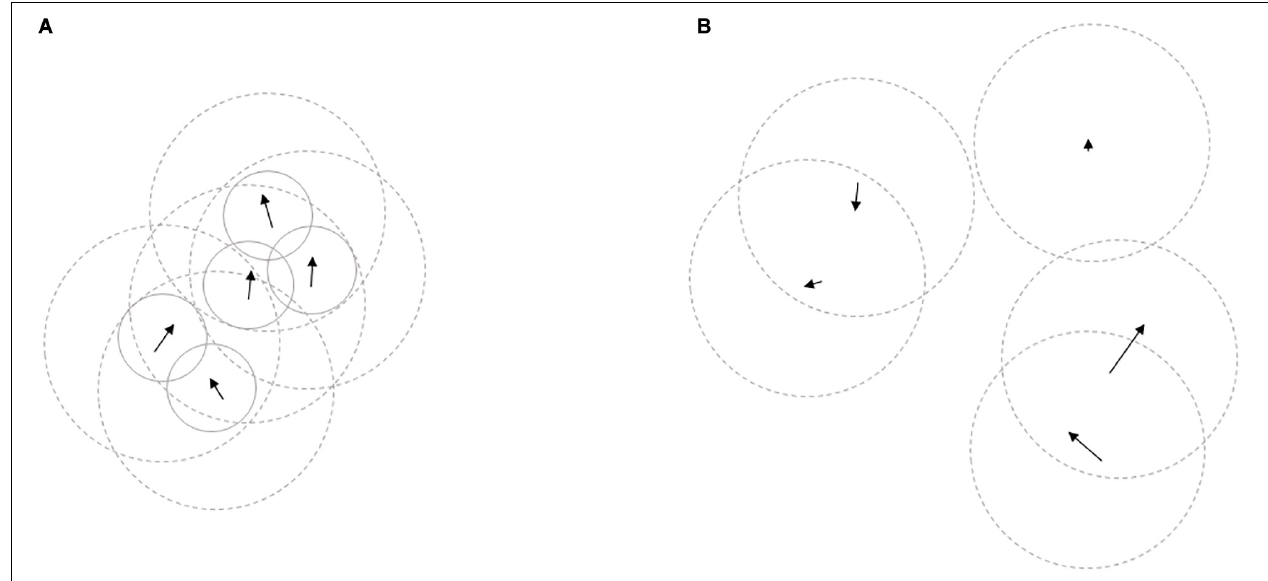
FIGURE 1 | General concept of the adopted distinction between animals living in cohesive groups and non-grouping animals. Arrows represent the movement vectors of individuals, solid circles denote the maximum distances within which animals maintain spatial proximity with their group-mates, dashed circles show their perception ranges. In (A) , members of a cohesive group exhibit social attraction toward group-mates and, as a result, maintain close spatial proximity. Due to such short inter-individual distances, perception ranges of group-members greatly overlap; social attraction often leads to synchronized movements as well. In (B) , there is no social cohesion among individuals, but through the observation of spatially distributed others within their perception range (or coming across remnants/scent marks at a different time) non-grouping animals have the possibility to detect social cues. Such cues are not limited to visual ones, but they can also be acoustic, chemical, and vibration-related, etc. For simplicity, perception ranges are only a function of